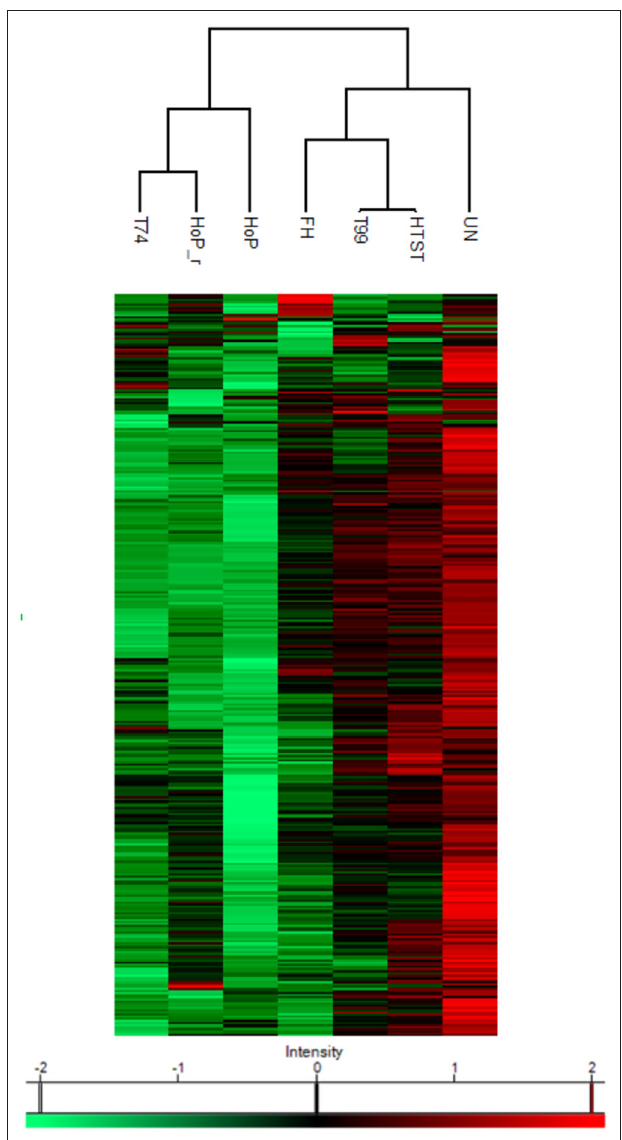
FIGURE 4 | Heat map indicating differences in protein profile of the differentially heated DHM samples. The color scale is based on z-score normalized iBAQ values and each row represents individual proteins. Hierarchical clustering was performed using a Euclidean distance metric. The analyses were performed in duplicate for each sample and all values are presented as mean ± standard deviation of two independent experiments UN, HTST, FH, T99, T74, HoP and HoP_r stand for untreated DHM, and DHM treated with high-temperature short-time, flash heating, high-temperature short-time with a thermomixer preheated at 99 ◦ C, high-temperature short-time with a thermomixer preheated at 74 ◦ C, holder pasteurization and holder pasteurization with rapid heating up-times,